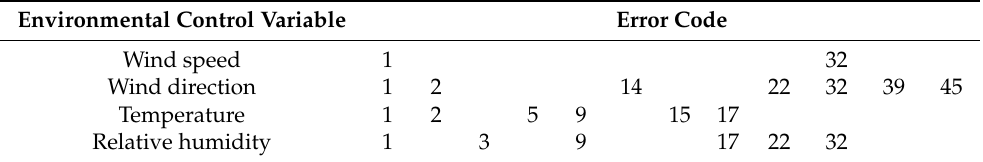
Table 6. Summary table of the study of significance by error and climate variable.